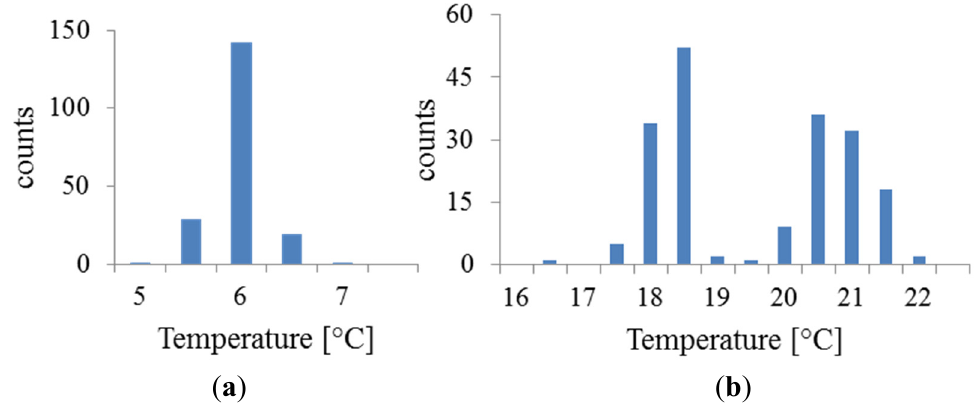
Figure 13. Temperature distribution within the two Smart Wheels’ battery packs before ( a ) and after ( b ) two hours of